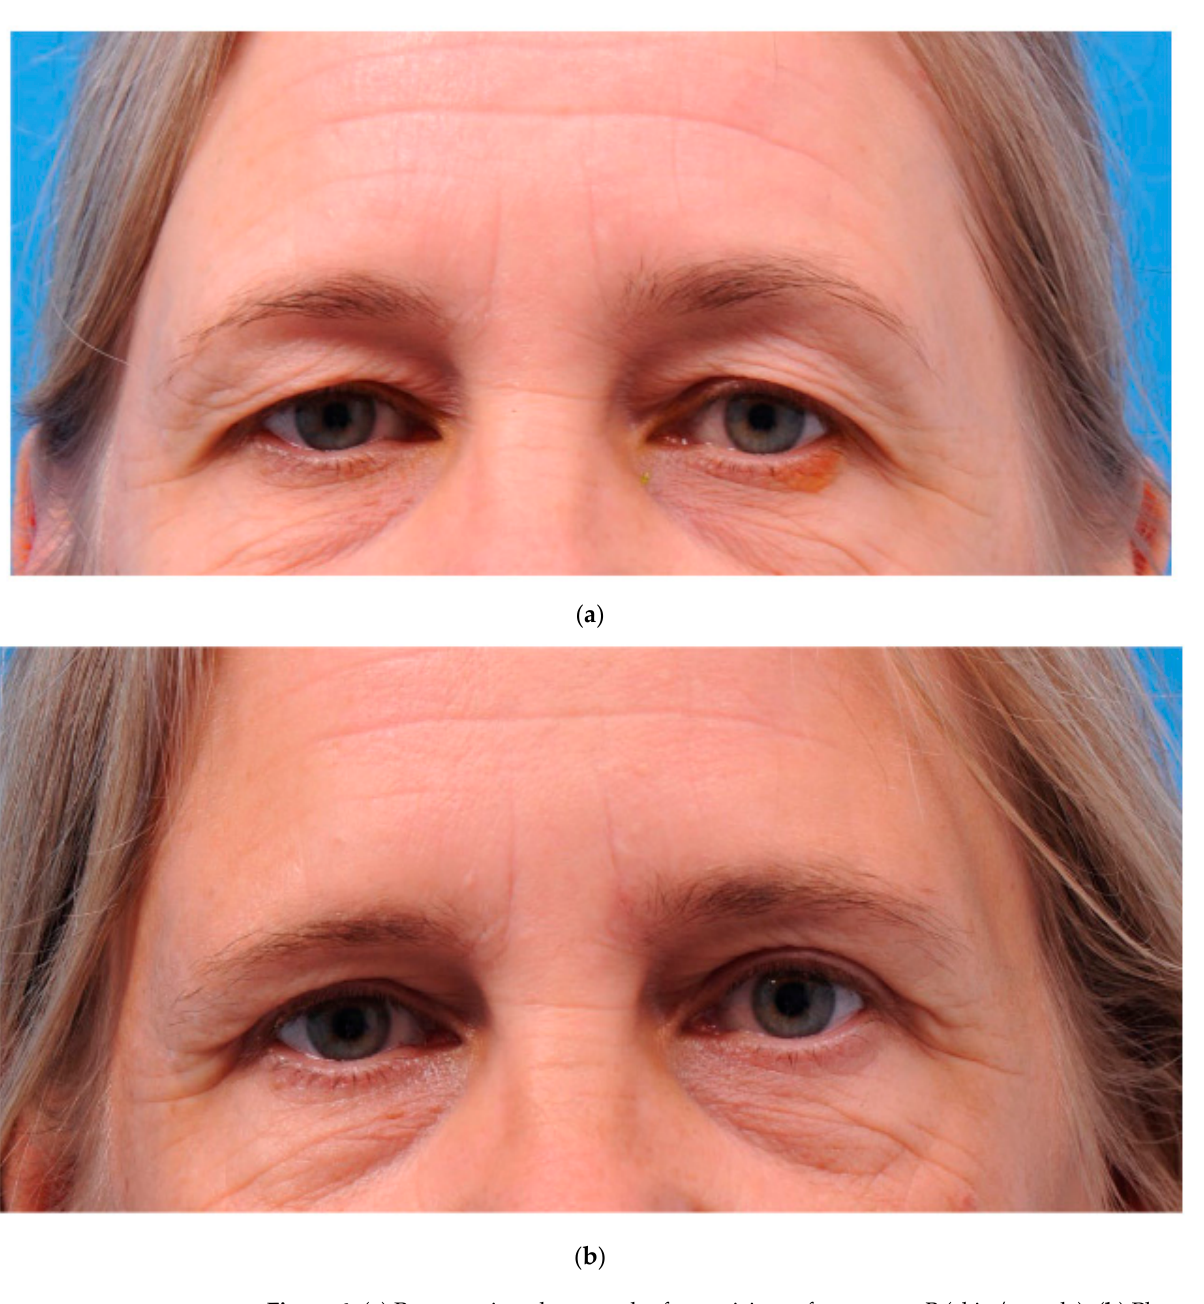
Figure 6. ( a ) Preoperative photograph of a participant from group B (skin/muscle). ( b ) Photograph 12 months after upper eyelid blepharoplasty (group B; skin/muscle).